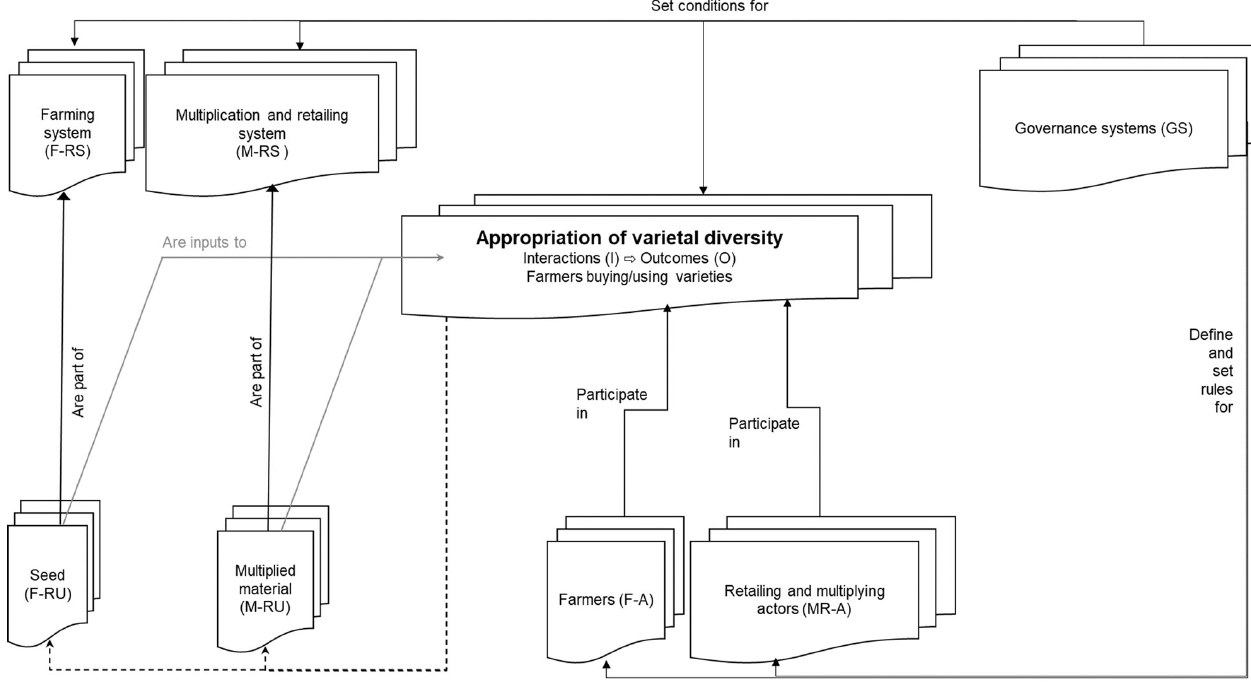
Fig. 4 . First-tier social-ecological system framework components appropriating varietal